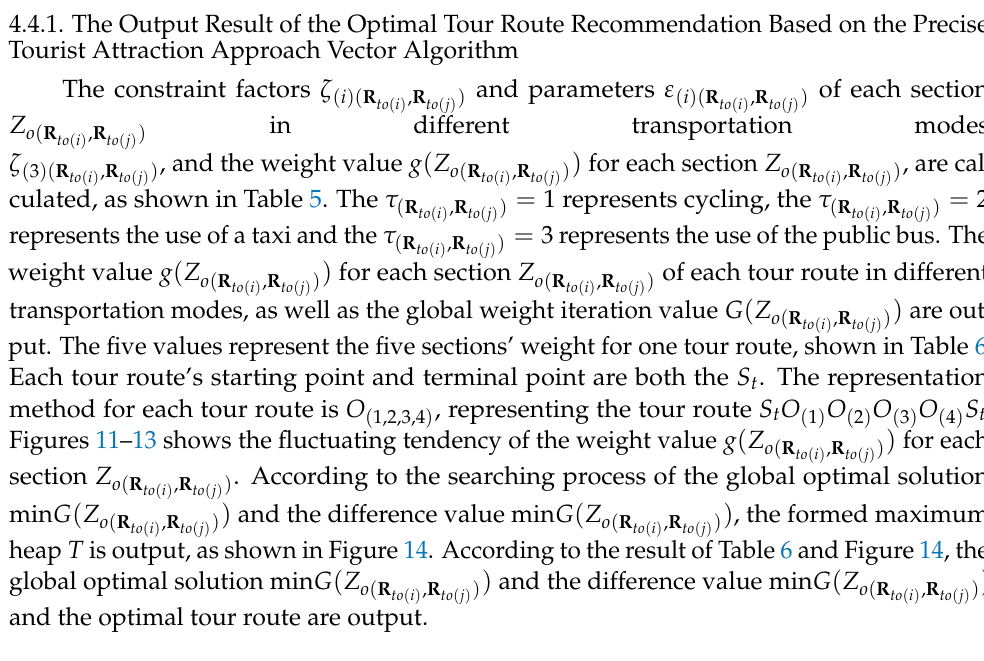
Figure 10. The tourist attraction geographic space directed weighted graph D .